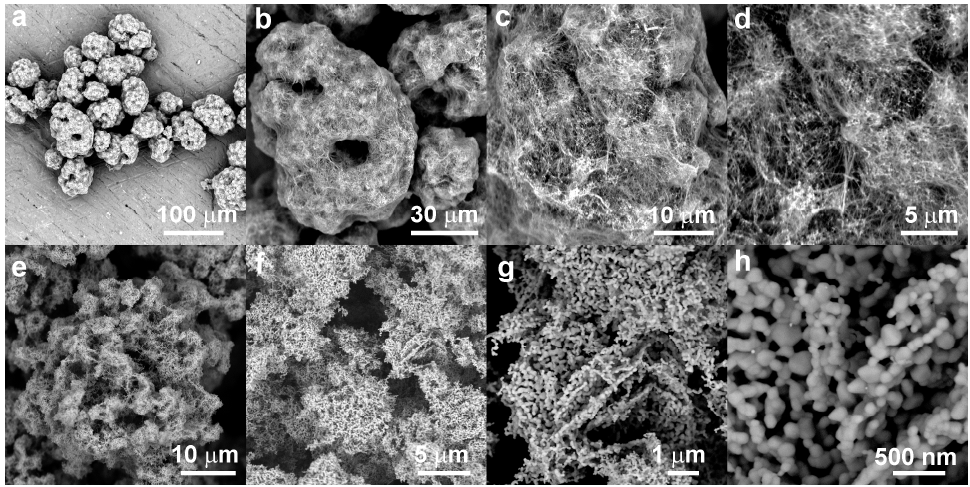
Figure 2. SEM microphotographs of the Ag-ZnO filler ( a – d ) before annealing and ( e – h ) after the annealing process.